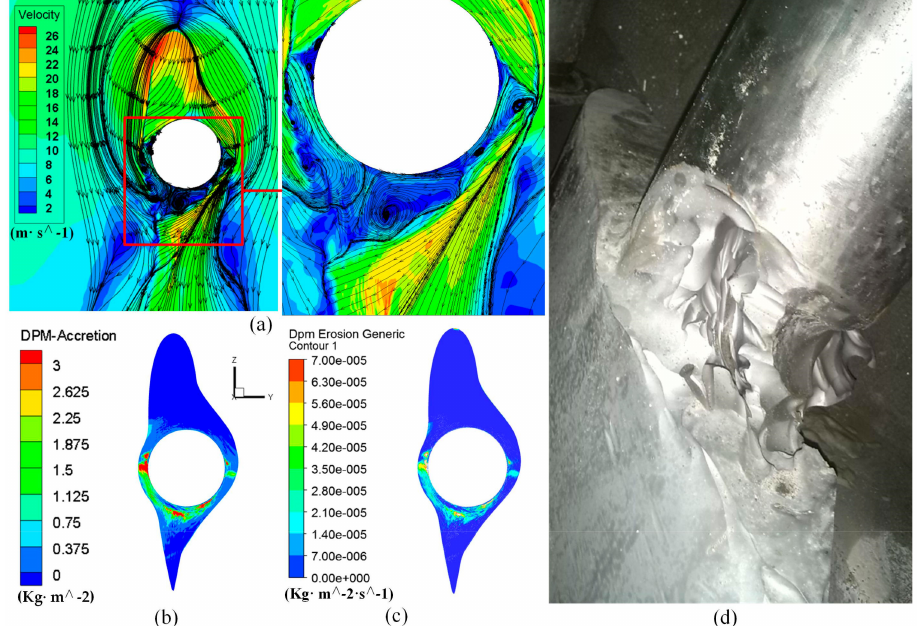
Figure 10. Comparison of wear morphology and flow field on the end-surface of the guide